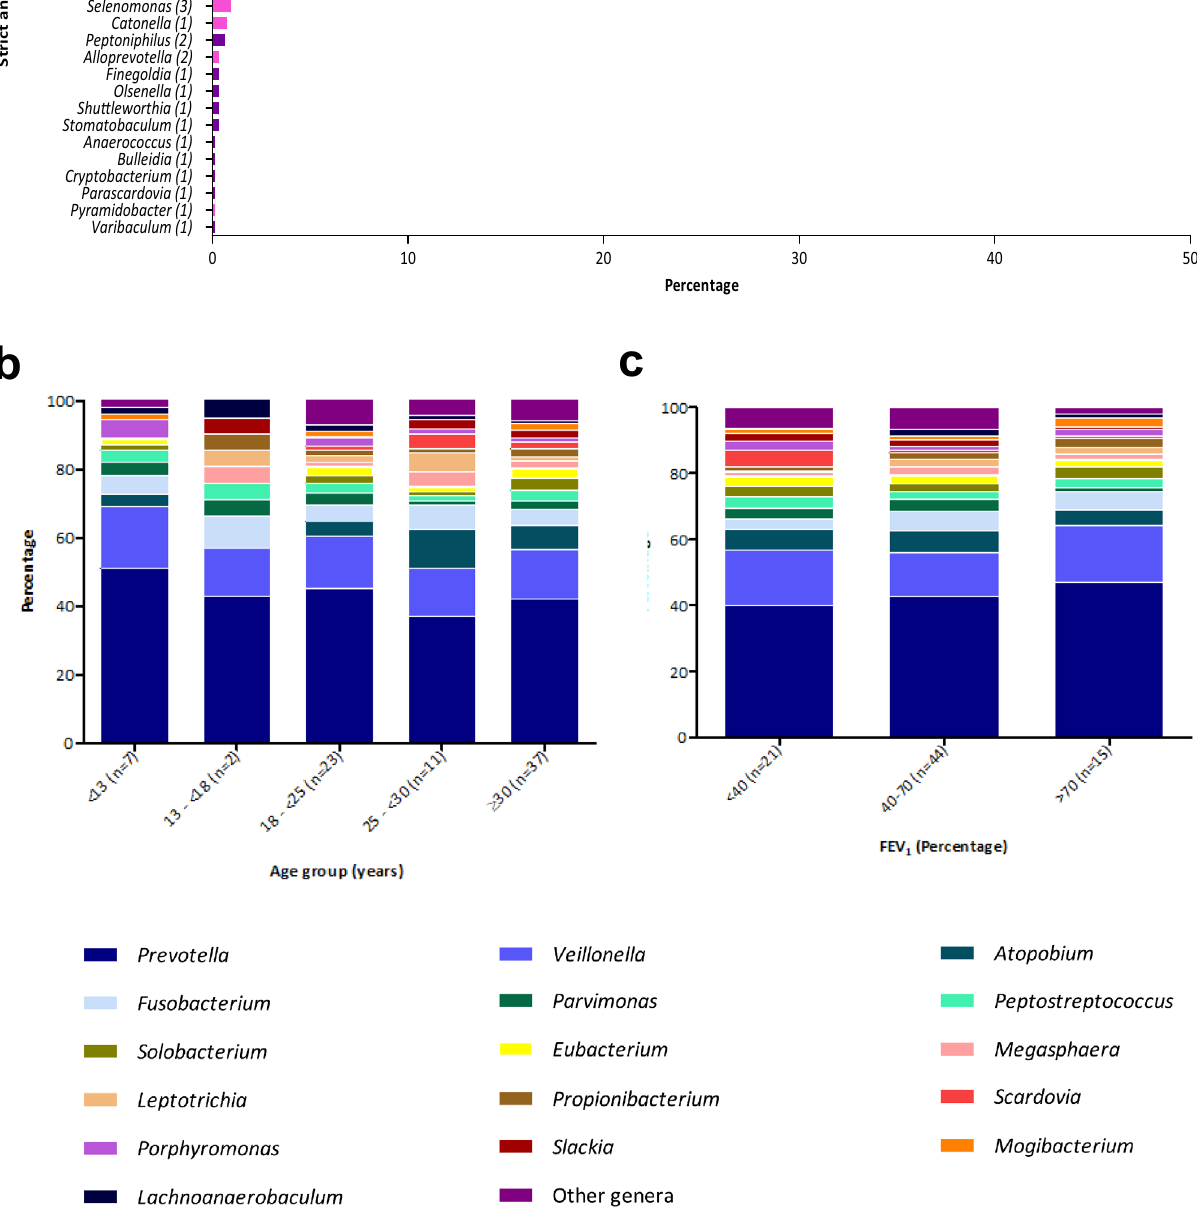
Figure 2. Extended-culture approach results. ( a ) Description of strict anaerobic genera identified in 112 sputum samples: Gram-positive genera are shown in purple, Gram-negative genera in pink, and number of species in brackets. ( b ) Prevalence of strict anaerobic genera identified according to patient age group (80 patients). ( c ) Prevalence of strict anaerobic genera identified according to patient lung function evaluated by Forced Expiratory Volume in one second (FEV 1 ) (80